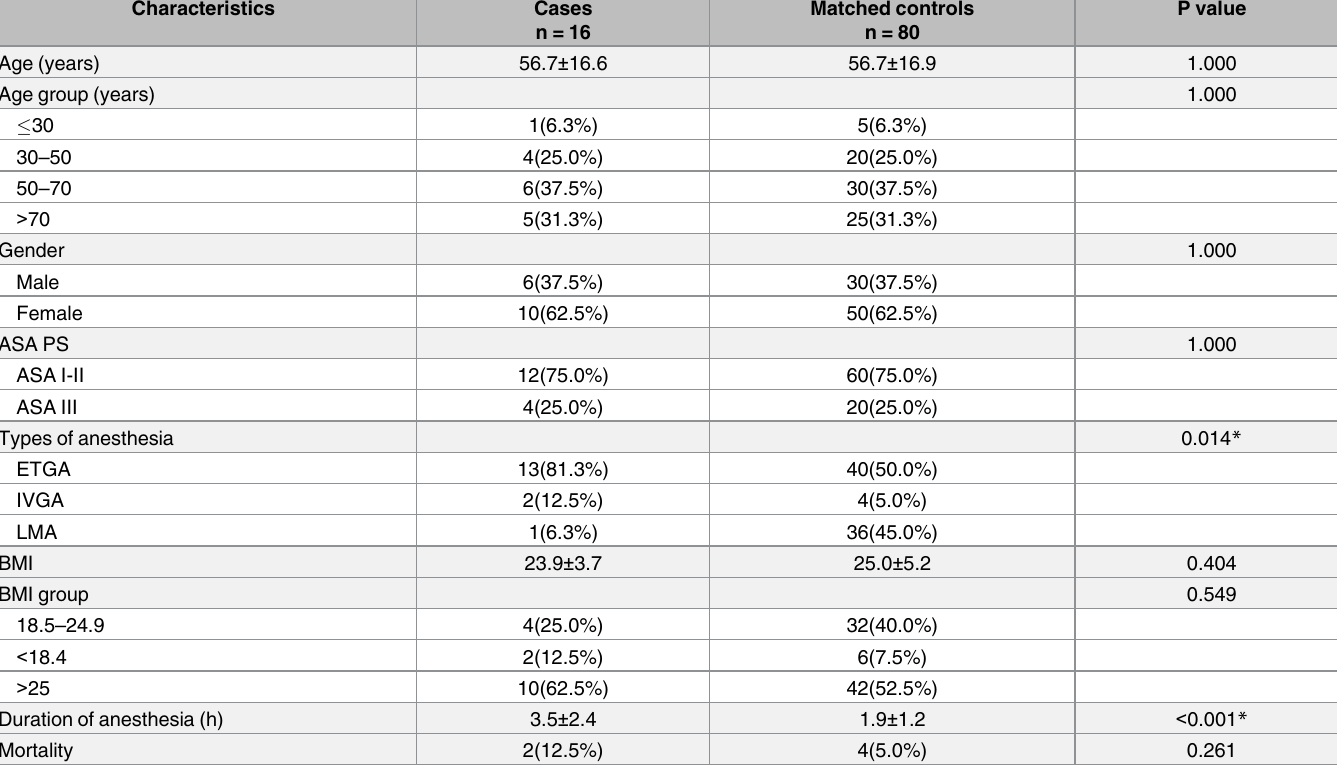
Table 3. Characteristic analysis of intraoperative awareness (casesvs matched controls).